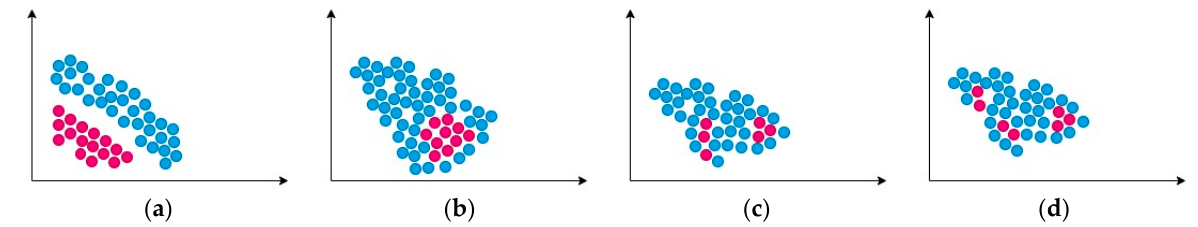
Figure 1. The schematic diagram of several data distributions in various scenarios with two-dimensional binary-class-imbalanced data. ( a ) Imbalanced Ratio, ( b ) Class Surrunding, ( c ) Class Overlapping, ( d ) Small Disjucts.